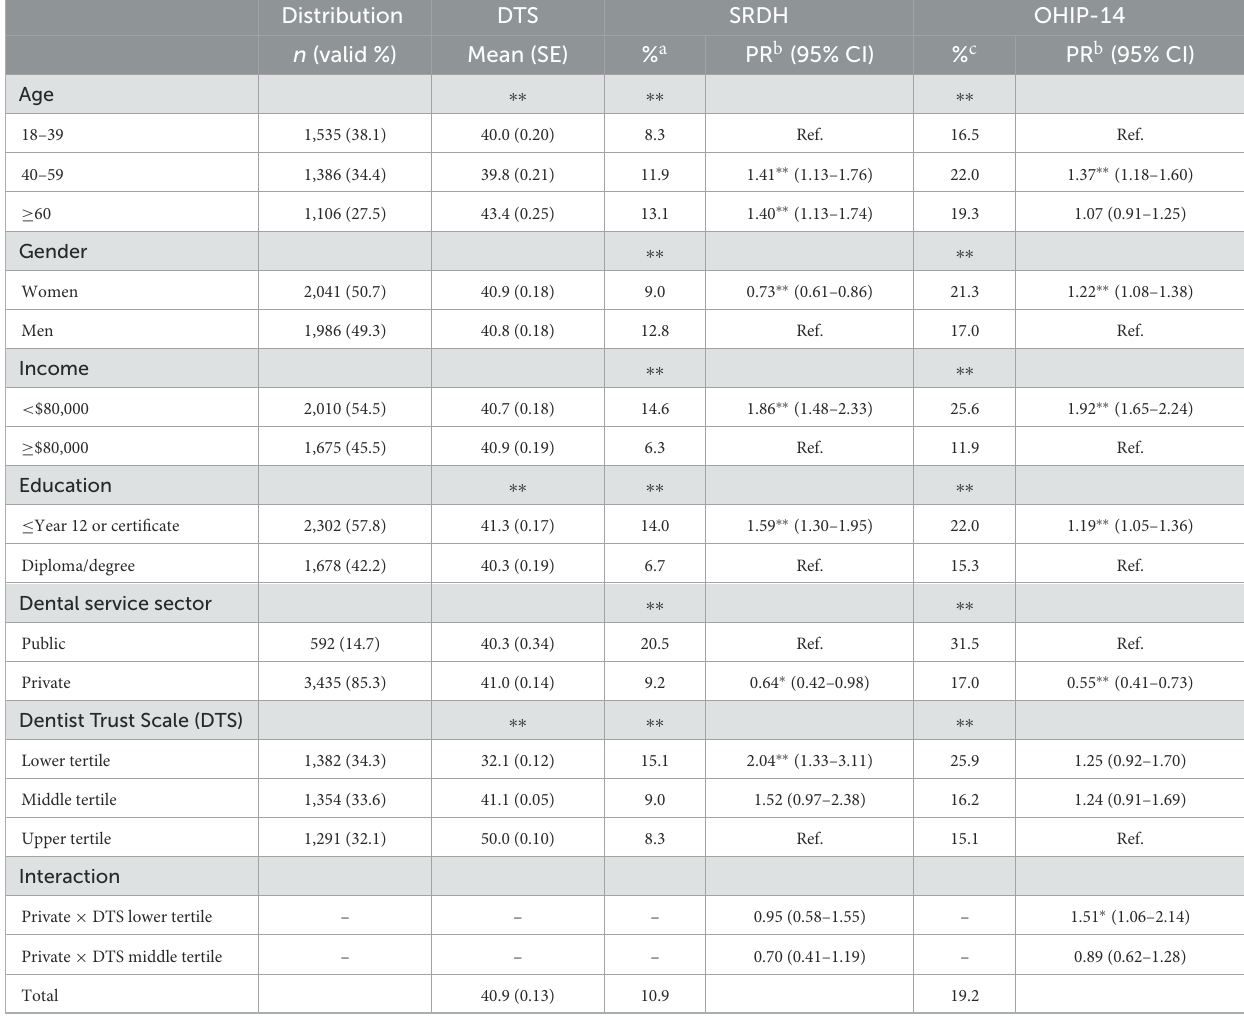
TABLE 1 Descriptive statistics and unadjusted/adjusted associations of oral health